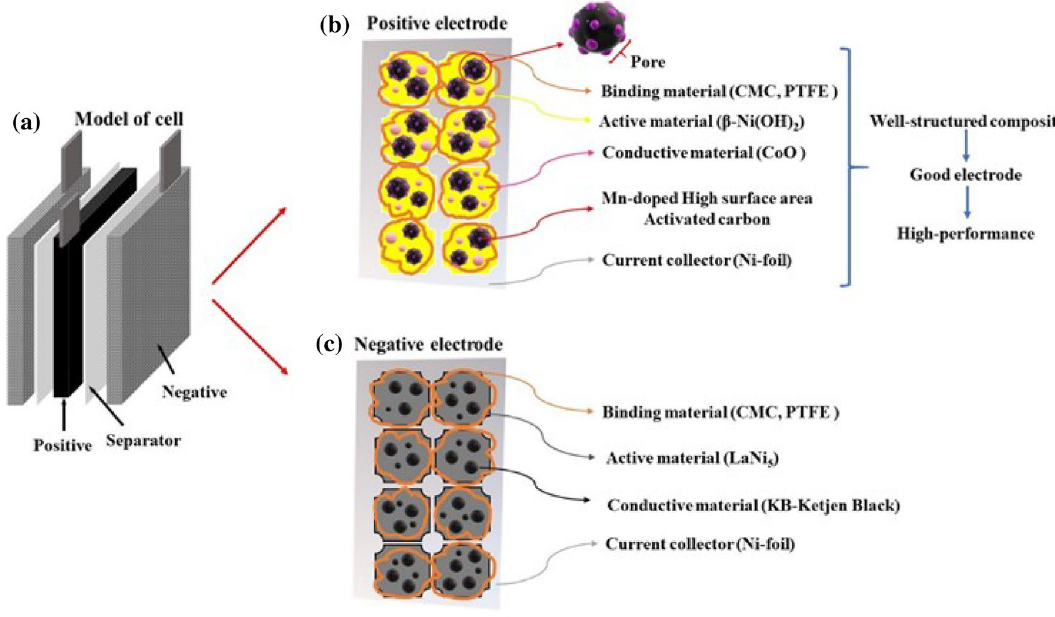
Figure 1. ( a ) Schematic illustration of the model of the Ni-hybrid capacitor, ( b ) detailed structure of the positive electrode, ( c ) detailed structure of the negative